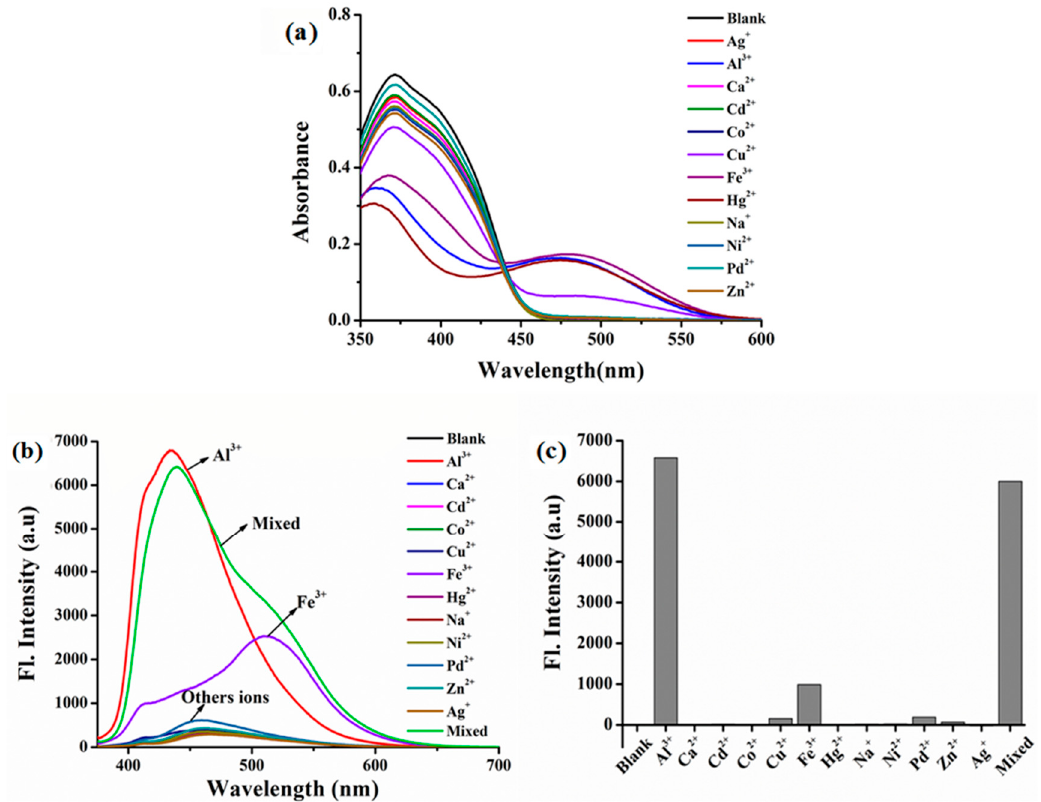
Figure 2. ( a ) Ultraviolet spectra of ITEC (10 μ M) in different metal ions (20 μ M). ( b ) Fluorescence responses of ITEC (10 μ M) to various metal ions (20 μ M) by excitation at 365 nm. ( c ) The bar graph of fluorescence intensity of ITEC at 431 nm.